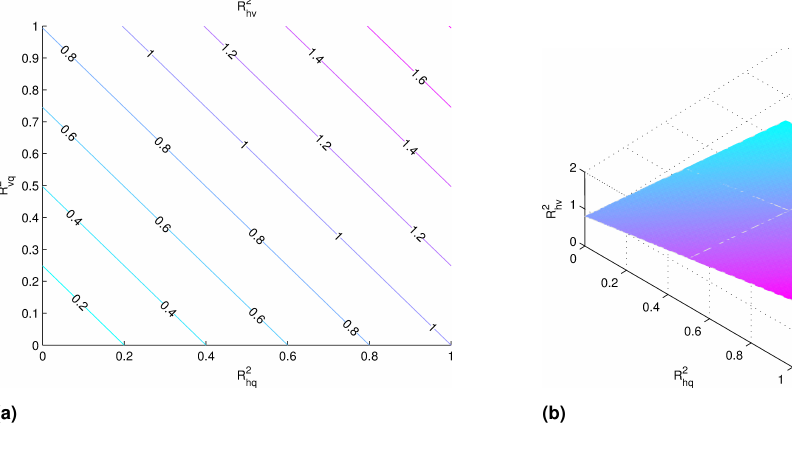
Fig. 2. Simulations of the leptospirosis model showing the effect of the optimal strategies: Prevention of humans and vaccination of